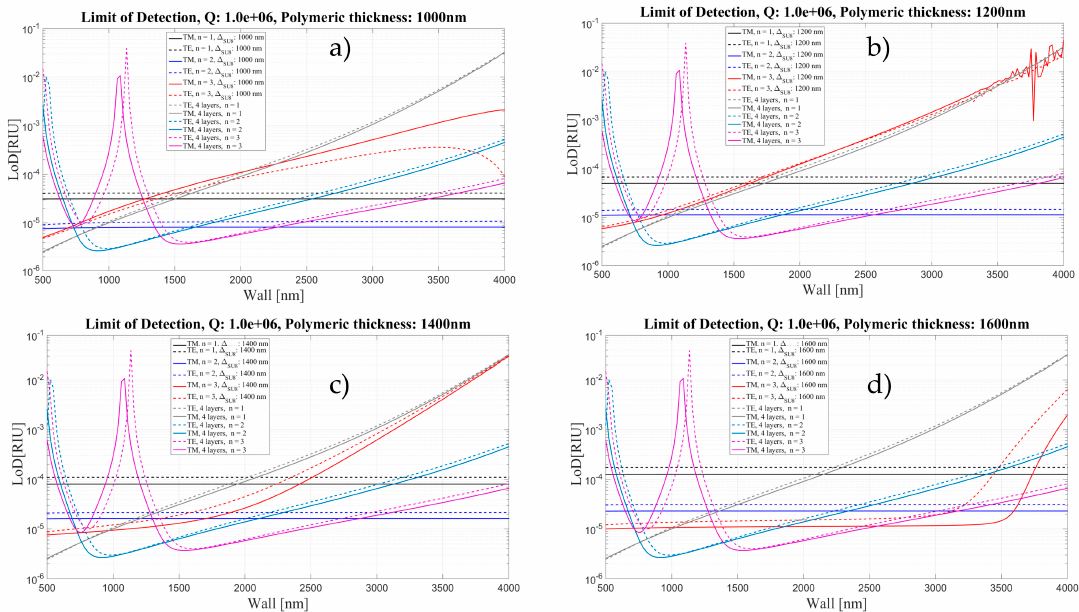
Figure 21. Limit of Detection for the four- and five-layer models as a function of Wall thickness for two different polarizations and three mode orders, corresponding to different thickness of polymeric layer: ( a ) 1000 nm; ( b ) 1200 nm; ( c ) 1400 nm; and ( d ) 1600 nm. Q is assumed to be about 10 6 .